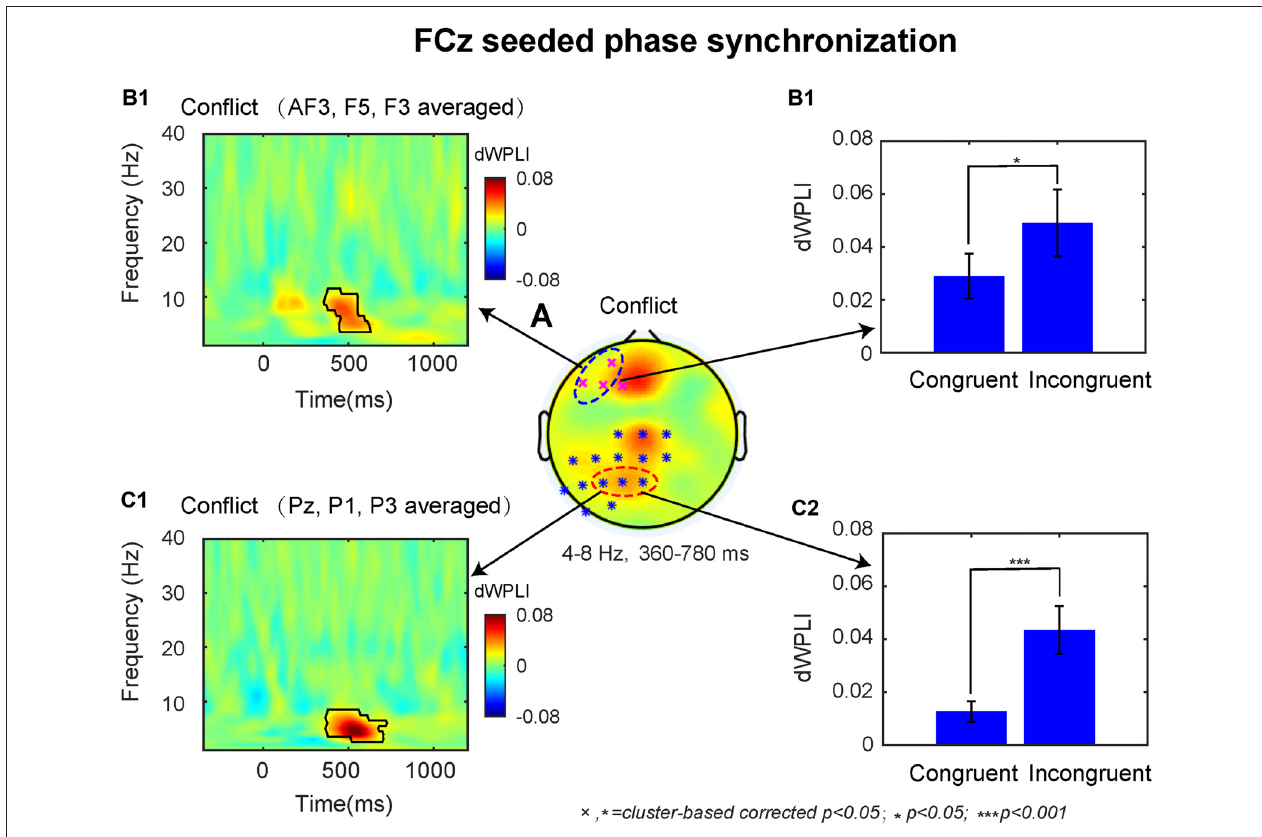
FIGURE 4 | The results of connectivity analyses. (A) The conflict effect at the FCz seeded phase synchronization in the time-window of 360–780 ms revealed two statistical clusters at p < 0.05. The TF plot (B1) and bar plot (B2) as a function of congruency across left dorsal lateral prefrontal cortex (DLPFC) electrodes (AF3, F5, F3). The TF plot (C1) and bar plot (C2) as a function of congruency across left posterior parietal cortex (PPC) electrodes (Pz, P1, P3). Each pixel in TF plots represent the debiased weighted phase lag index (dWPLI) values. Black contours in TF plots outline regions that are statistically significant at p < 0.05 and corrected for multiple comparisons using cluster based statistics